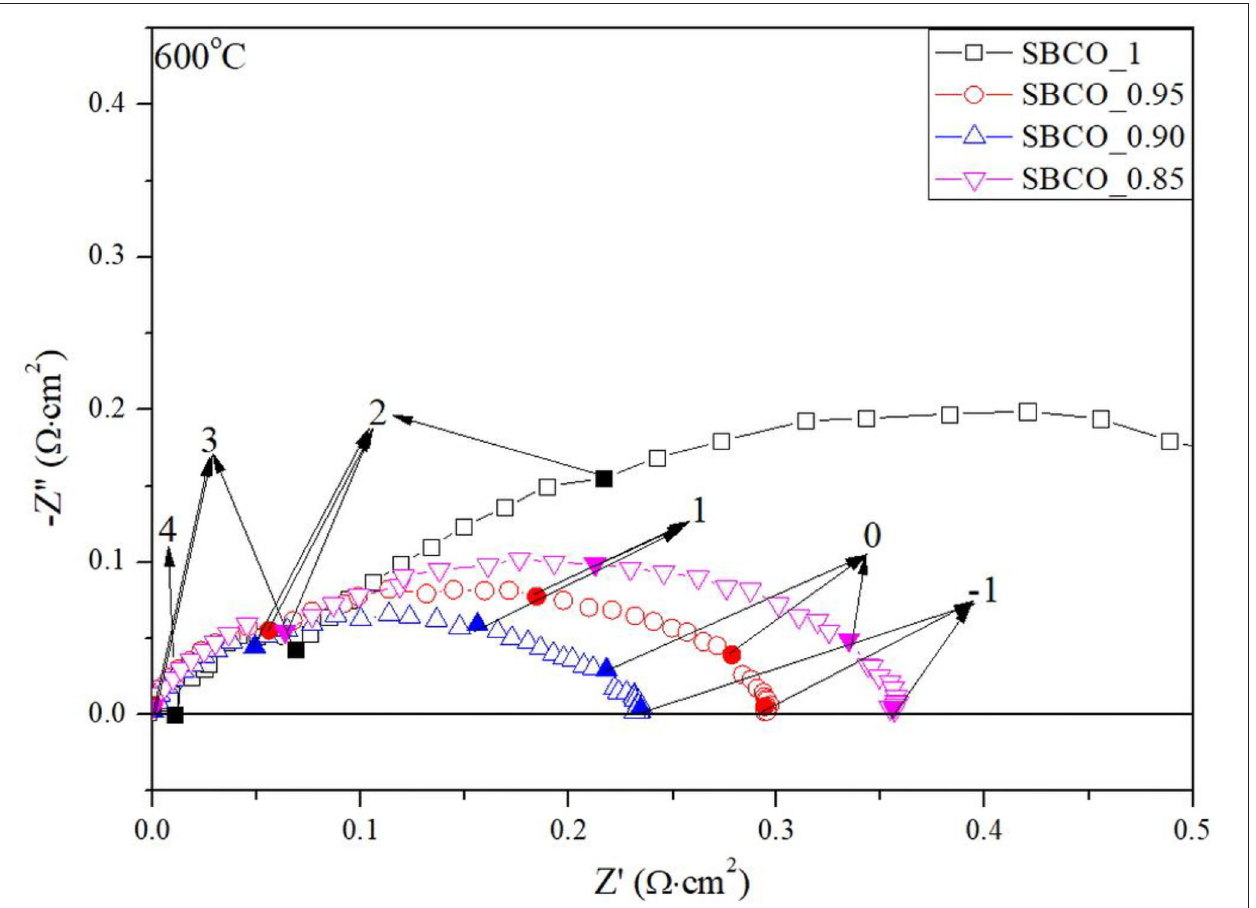
FIGURE 4 | Impedance results of Sm 1 − x BaCo 2 O 5 + d ( x = 0, 0.05, 0.10, and 0.15) measured at 600 ◦ C. For exact comparisons of ASRs, ohmic resistances were removed in these results; inset numbers denote logarithm of measuring